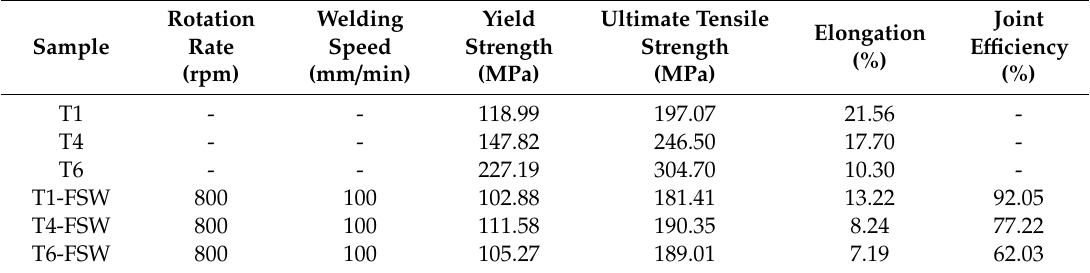
Table 1. Tensile properties of the BMs and the FSW